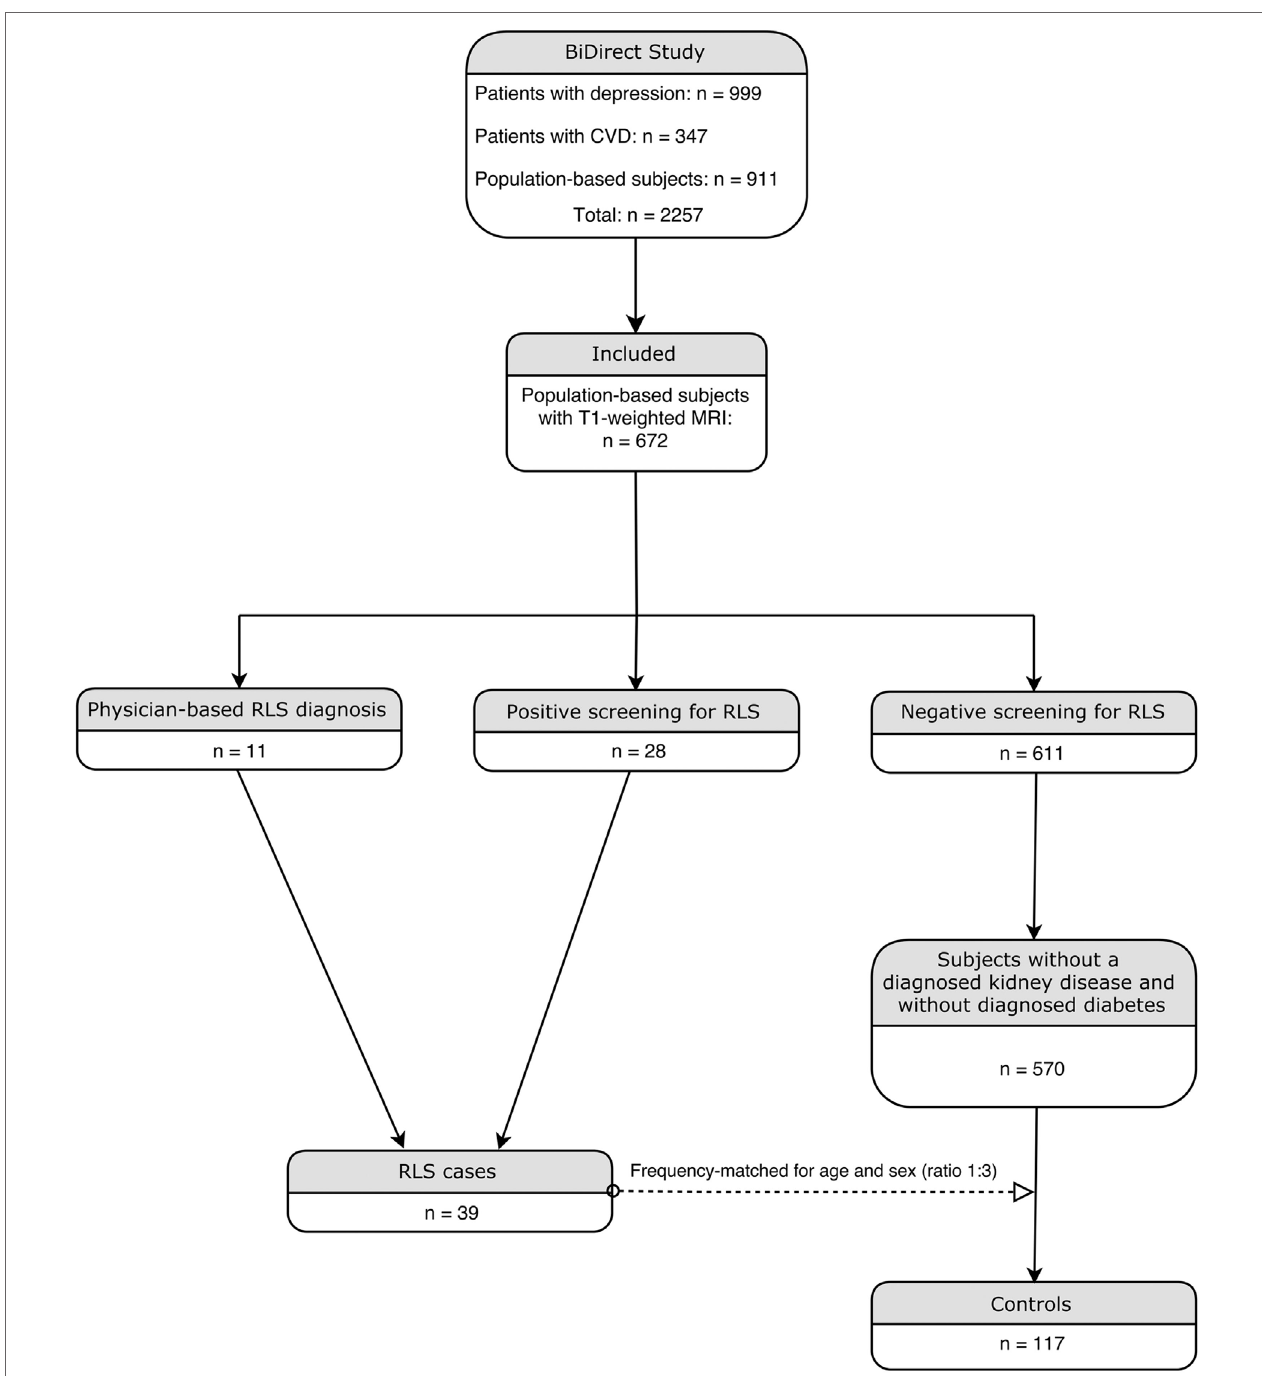
FigUre 1 | Flowchart illustrating the inclusion